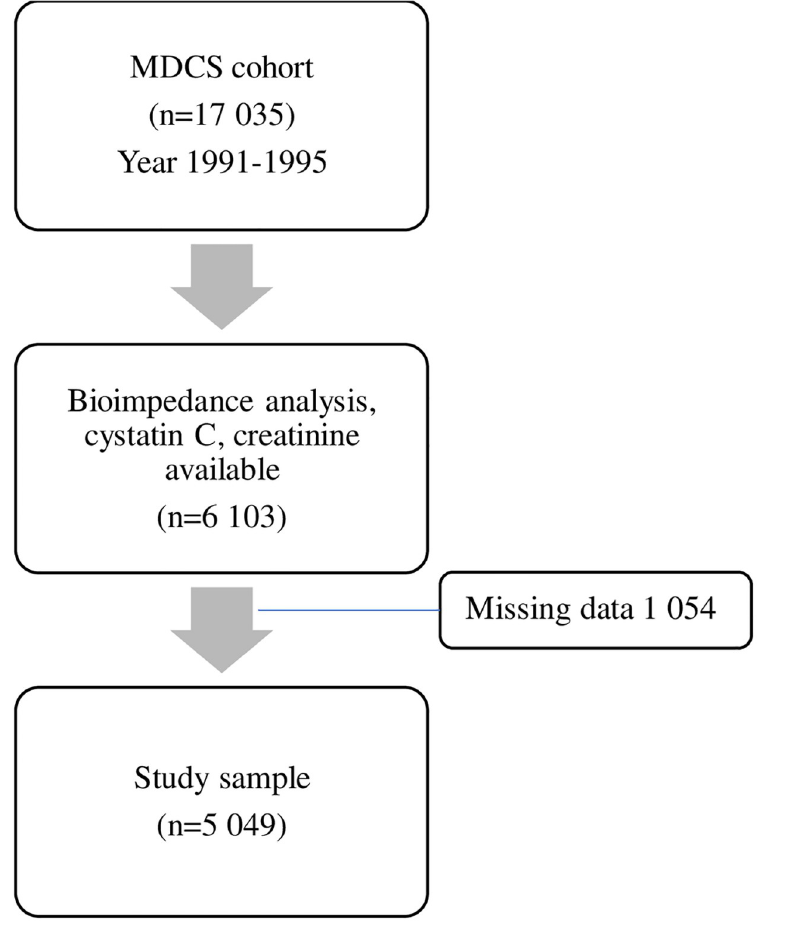
Fig 1. Selection of subjects for a study. MDCS, Malmo Diet Cancer study.